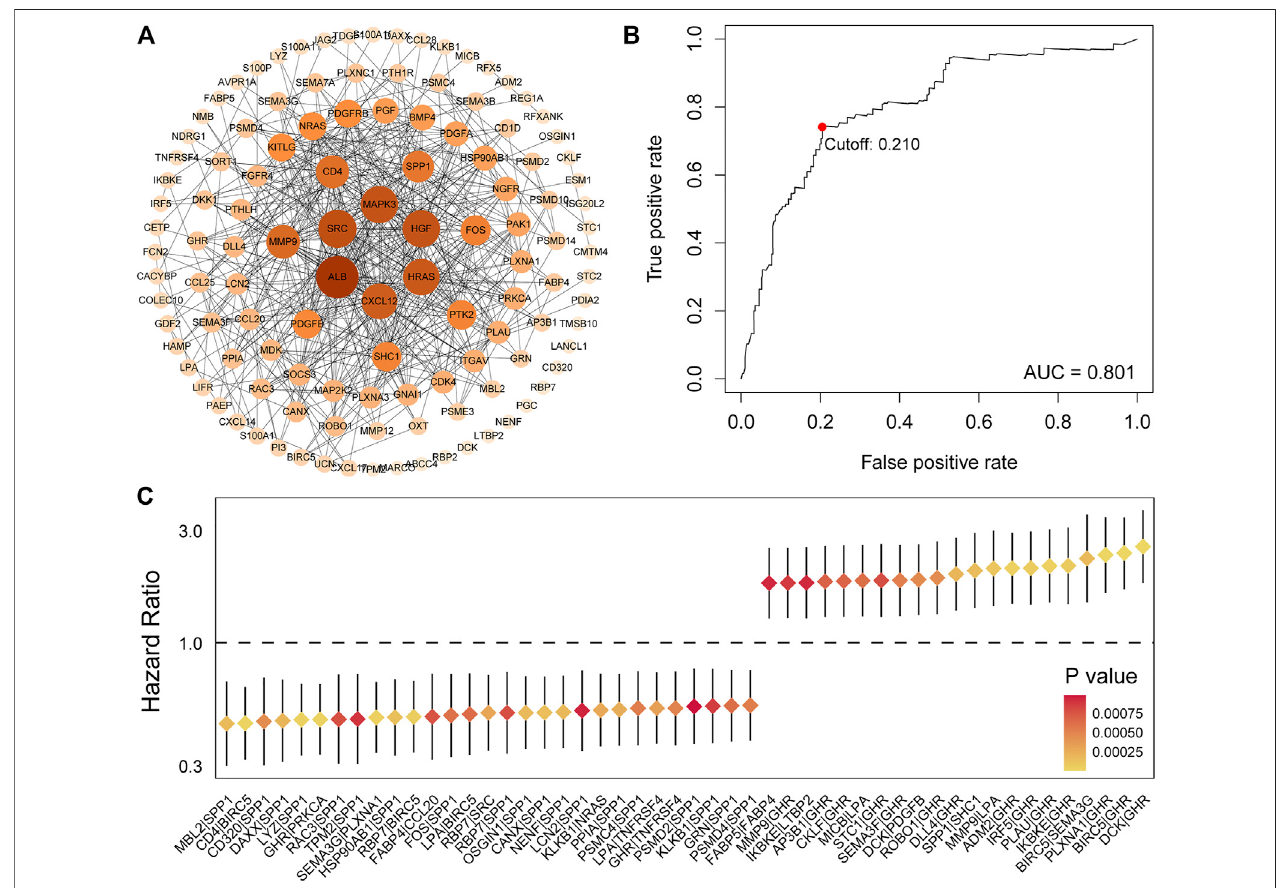
FIGURE 1 | Identi fi cation of IRGs and determination of risk score. (A) 120 shared differential immunity related genes were displayed on the protein-protein interactionnetwork. (B) UnivariateCoxanalysisobtained50IRGPsrelated toprognosis. (C) ROCcurveoftheriskscoreoftheIRGPssignatureintheTCGAcohort.The risk score was 0.210, which served as a threshold for classifying patients into the high and low-risk patients.